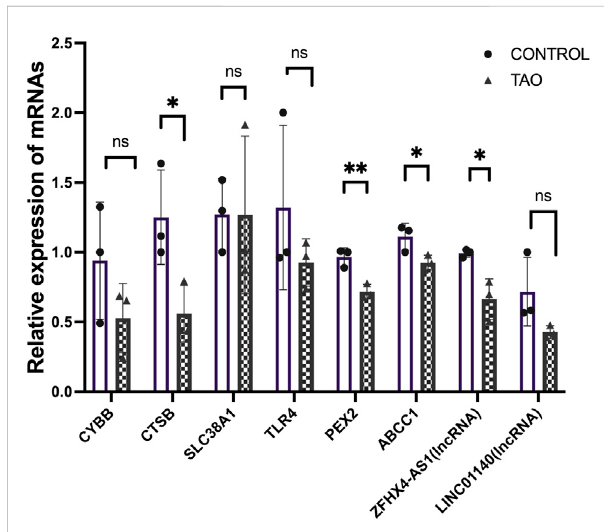
FIGURE 9 Experimental validation of six FRGs and FR-lncRNAs in OFs cultured from the healthy control and TAO patients. Ns: p > 0.05, * p < 0.05, ** p <